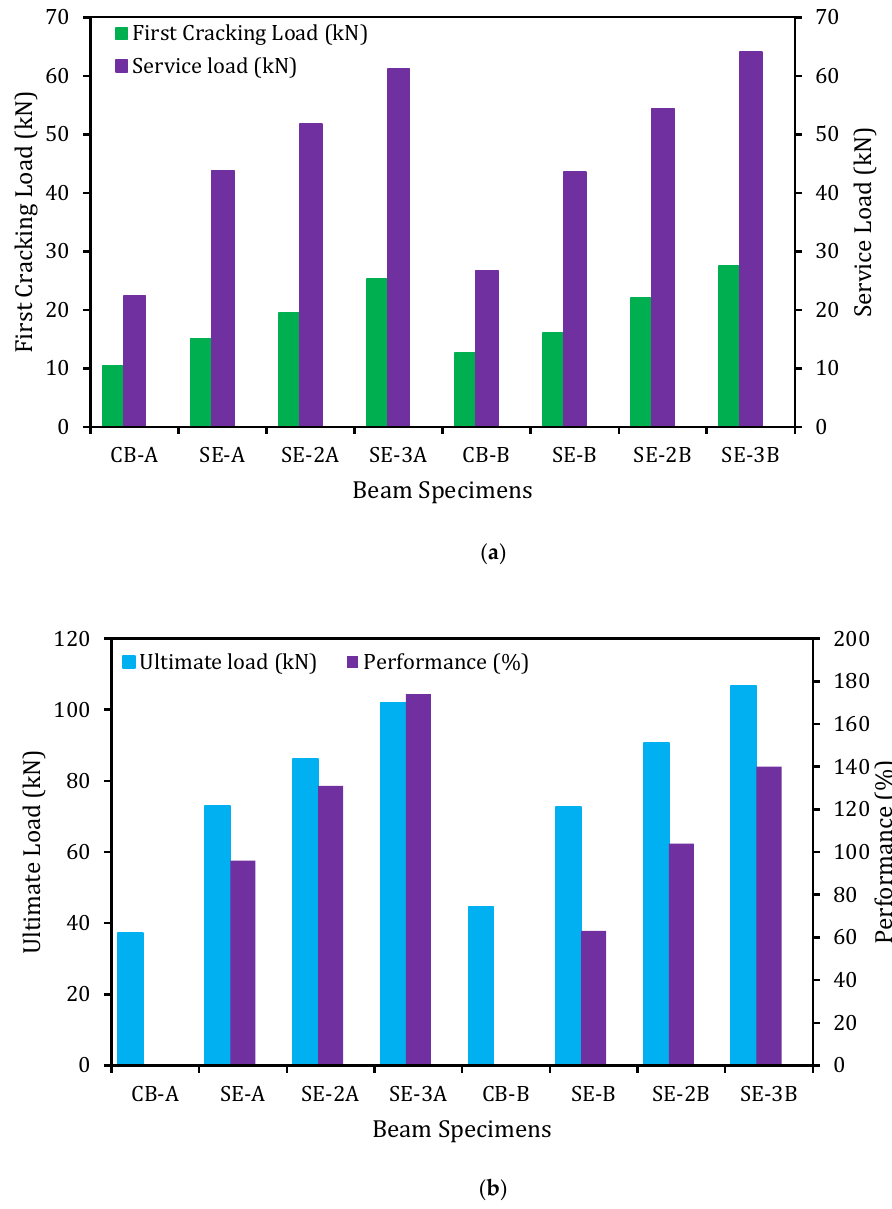
Figure 6. Flexural loads improved by E-SBR technique. ( a ) First cracking and service load. ( b ) Ultimate